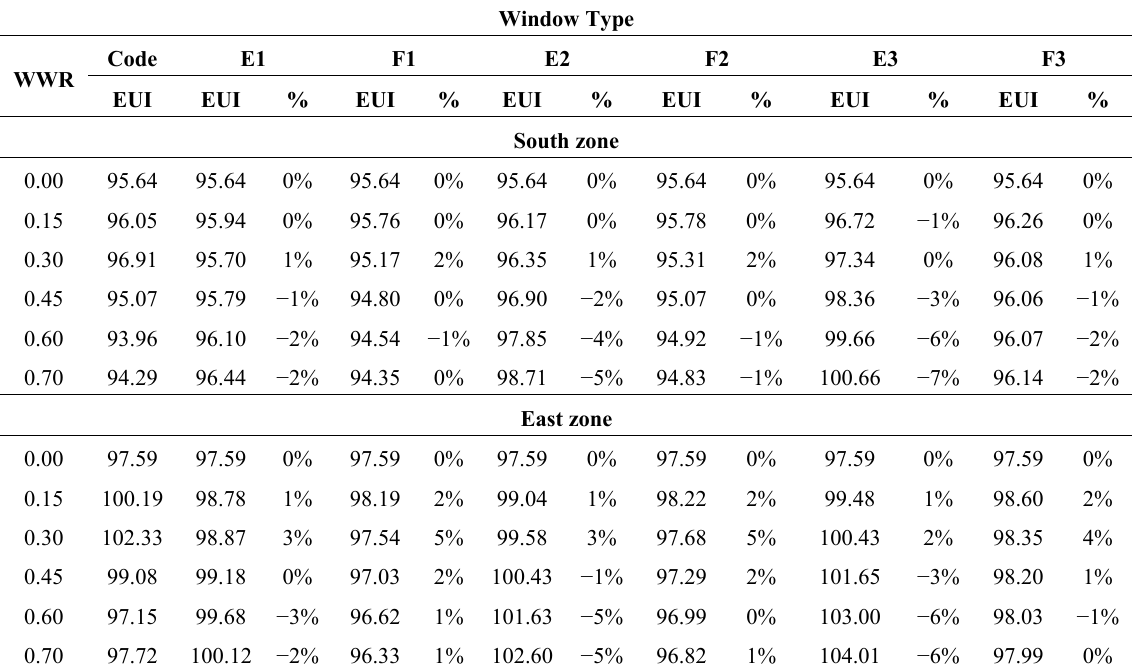
Table 9. District heating energy consumption (MJ/m 2 -year) and percent savings compared to the GB 50189-2005 Standard for